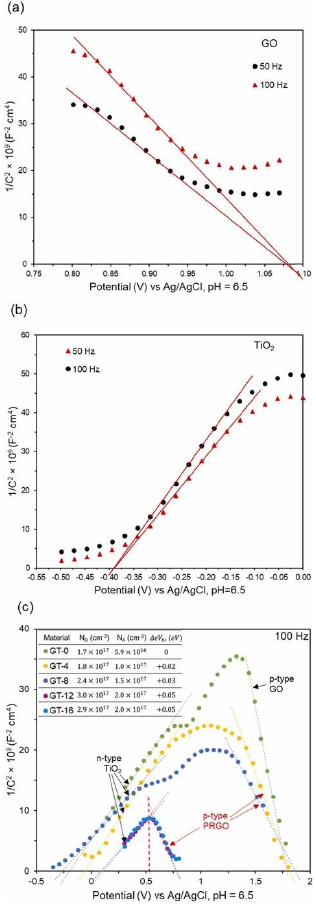
Figure 7. ( a ) MS plot of GO, ( b ) MS plot of TiO 2 , and ( c ) MS plot of GO/TiO 2 composite. Reprinted with permission from [145]. Copyright Elsevier. After the conversion using Equation (11), the flat-band potential readings of the p- type GO and n-type TiO 2 were 1.26 V and −0.21 V (vs. NHE, pH 7), respectively. The flat- band potential for the p-type semiconductor is 0.10 to 0.30 V lower than the reading of 𝐸 𝑉𝐵 whereas the flat-band potential for the n-type semiconductor is 0.10 to 0.30 V higher than the reading of 𝐸 𝐶𝐵 [144]. Therefore, the 𝐸 𝑉𝐵 of p- type GO was 1.56 V, while the 𝐸 𝐶𝐵 of n-type TiO 2 was −0.51 V (vs. NHE, pH 7). Using Equation (9), the 𝐸 𝐶𝐵 of GO and 𝐸 𝑉𝐵 of TiO 2 were determined to be − 1.94 V and 2.59 V, respectively. After confirming both the 𝐸 𝐶𝐵 and 𝐸 𝑉𝐵 readings, the overall photocatalysis mechanism of the GO/TiO 2 composite can be estimated. Figure 8 demonstrates the mechanism of GO/TiO 2 composite.